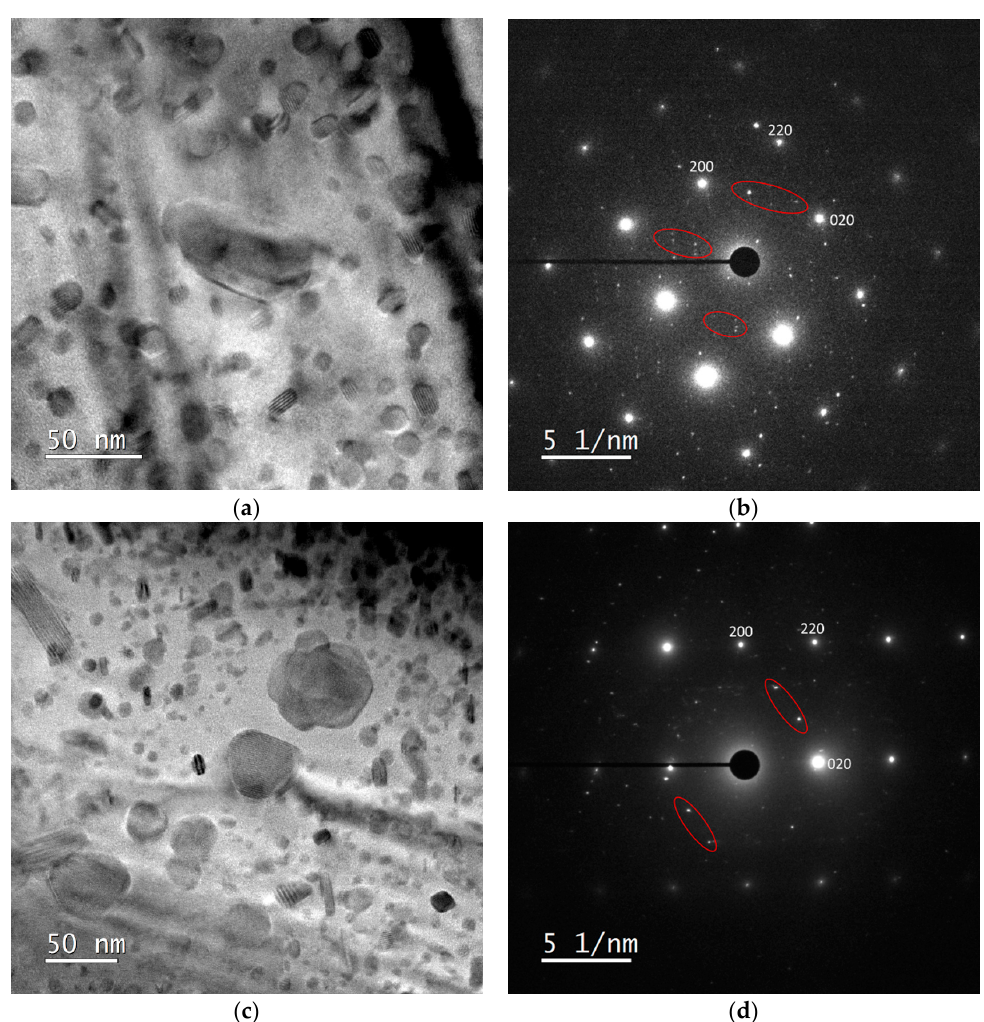
Figure 5. TEM photographs and diffraction patterns of MgZn 2 precipitate in ( a ) and ( b ) SO sample; ( c ) and ( d ) HC sample.